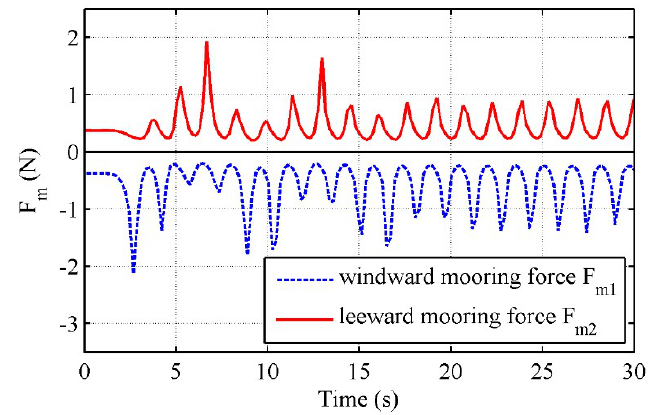
Figure 12. The time sequences of the mooring force for a moored floating box in waves. Table 2. The comparison of measured and present numerical response amplitude operators (RAO) of the mooring forces. RAO Experimental Data [26] Present Result RAO (F m1 ): N/cm